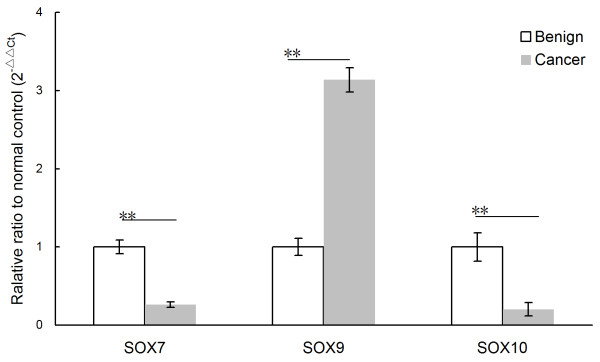
Validation of gene microarray data by real-time quantitative RT-PCR (qRT-PCR). Three genes were subjected to QRT-PCR in the mRNA from ten pairs of PCa and adjacent benign prostate tissues. The significant down-regulation of SOX7 and SOX10 and up-regulation of SOX9 were detected in PCa tissues (n = 10) than that in the corresponding adjacent benign prostate tissues (all P < 0.01). Relative expression ratio is defined as the expression levels of the gene to those of the internal reference gene, β-actin. The assays were carried out in triplicate and means ± standard deviations were plotted.